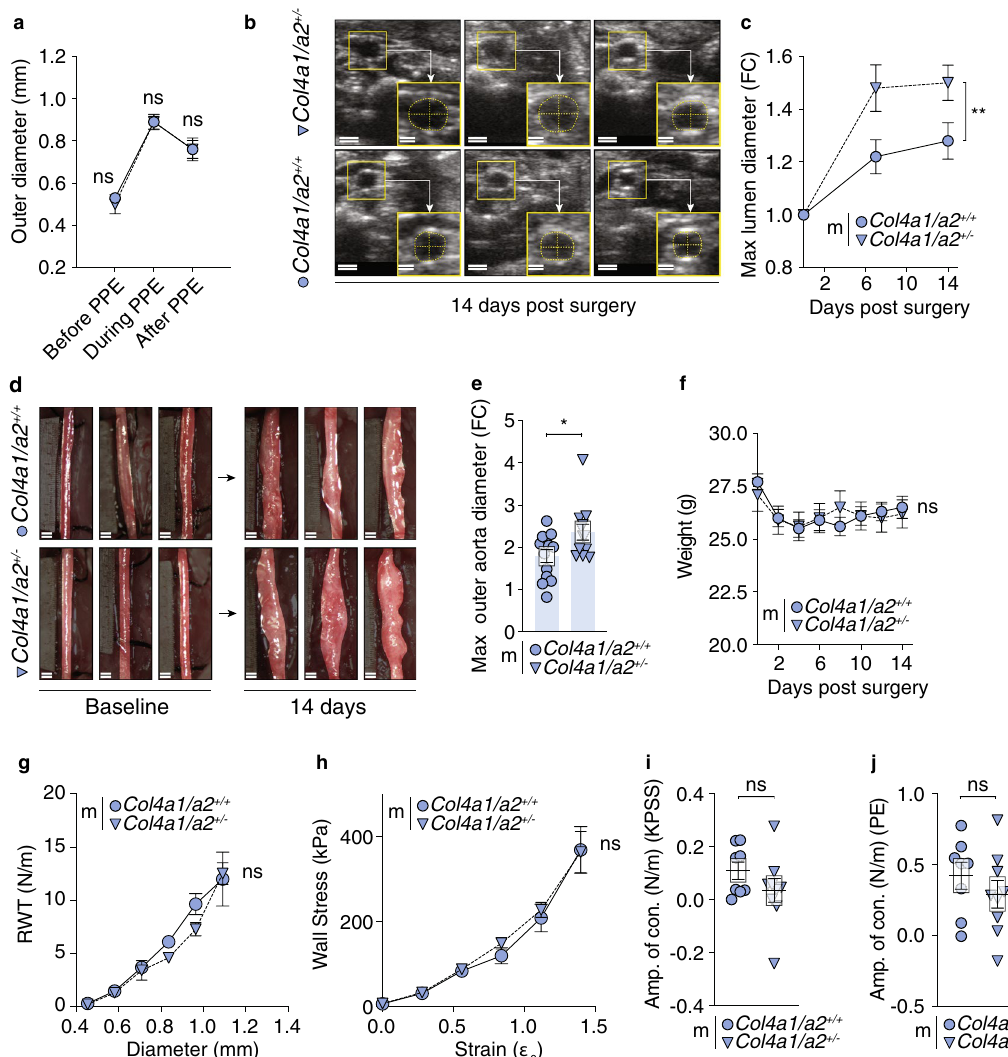
Figure 2. Col4a1/a2 hemizygosity augments experimental AAA development. ( a ) Outer aorta diameter before, during and after porcine pancreatic elastase (PPE) surgery as assessed by direct measurement during surgery. ( b ) Representative ultrasound images from six mice (3 Col4a1/a2 + /− vs. 3 Col4a1/a2 + / + ) 14 days post surgery. Scalebars (overview) = 1 mm; Scalebars (magnification) = 500 µm. ( c ) Maximal lumen diameter measured by ultrasound, expressed as foldchange (FC) relative to baseline diameter. ( d ) Representative images captured from video recordings of aortas from six mice (3 Col4a1/a2 + /− vs. 3 Col4a1/a2 + / + ) immediately prior to PPE infusion (baseline) and 14 days post surgery. Background has been shaded to assist visualization in print. Scalebars = 0.5 mm. ( e ) Maximal outer aorta diameter measured directly, expressed as FC relative to baseline diameter. For c and e, graphs showing absolute values are presented in Supplementary Fig. 2a,b. ( f ) Weight of Col4a1/a2 + /− mice and Col4a1/a2 + / + littermates before PPE surgery and during the 14 days of AAA development. ( g , h ) Raw diameter and resting wall tension measurements from the wire myography normalization procedure ( g ) and the stress strain relationship ( h ) derived from here. ( i , j ) Contractile amplitude of the abdominal aorta in response to 80 mM potassium solution (KPSS) ( i ) and 10 µM phenylephrine (PE) ( j ) as assessed by wire myography. Data are presented as mean ± SEM. * p ≤ 0.05, ** p ≤ 0.01, ns = non-significant. Unpaired t-test was used in ( a , e , and i – j ). Two-way ANOVA was used in ( c and f – h ). n per group (PPE experiment) = 14–15. n per group (wire myography experiment) = 6–9. m =